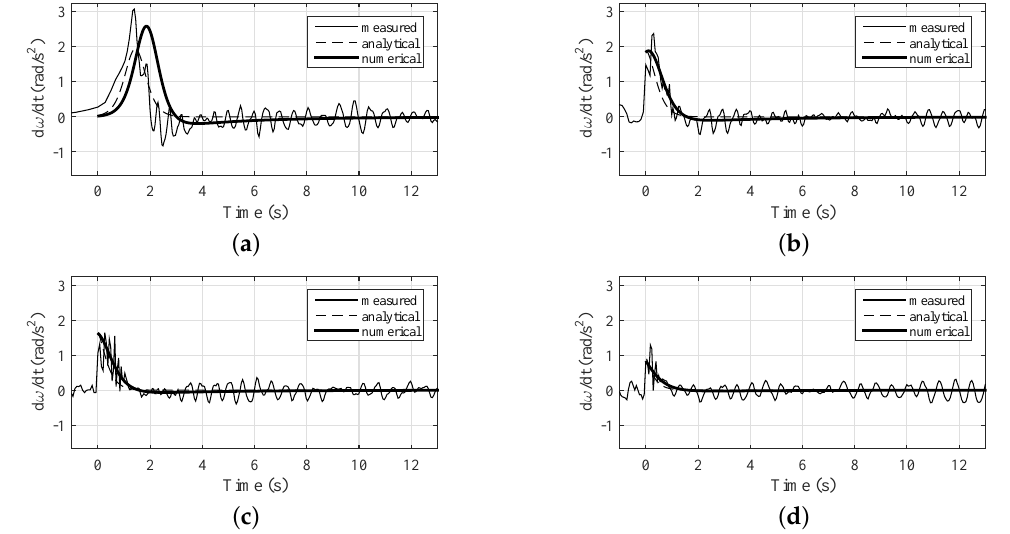
Figure 5. Comparison of time derivatives of model predictions and measured results. Cases are specified in Table